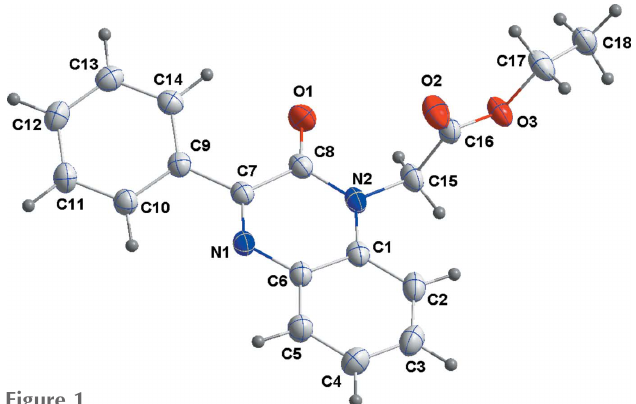
Figure 1 The title molecule with labelling scheme and 50% probability